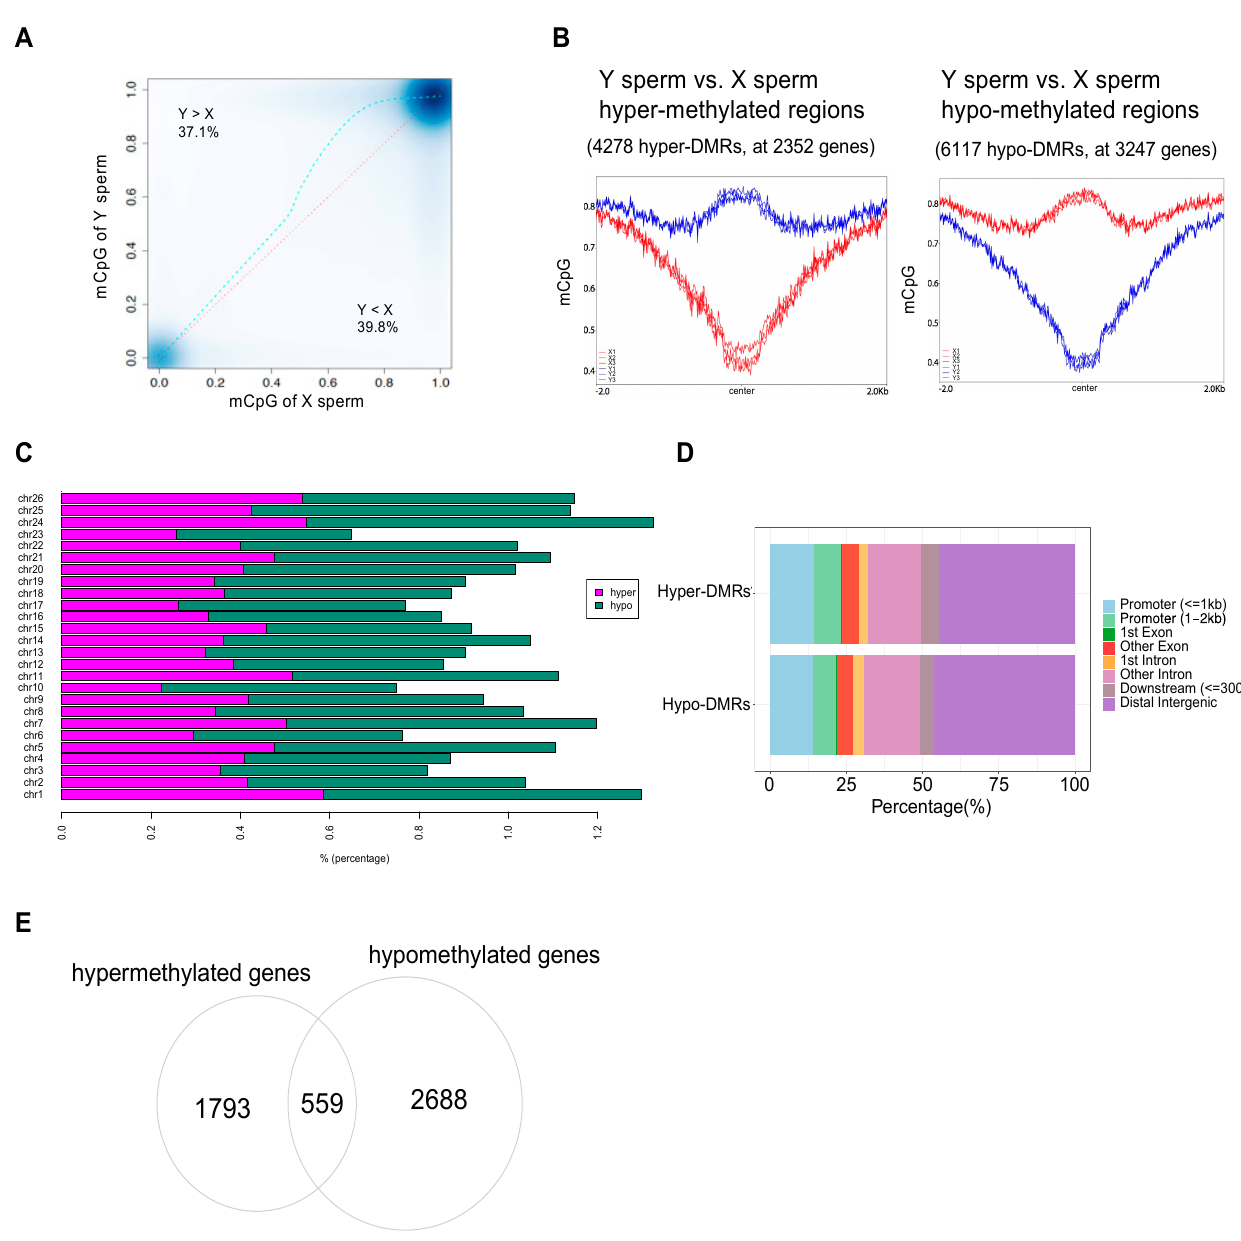
Figure 3. Genome-wide analysis of DNA methylation in X sperm and Y sperm. ( A ) Genome-wide hyper and hypomethylated CpG sites (Y sperm vs. X sperm). The red line represents the best fitting of linear regression, and the blue line is the smooth curve (Lowess method). ( B ) Average CpG methylation levels over ± 2 kb of all differentially methylated regions (DMRs) from Y sperm vs. X sperm. Left: hypermethylated regions; right: hypomethylated regions. Red: X sperm; blue: Y sperm. The thresholds for filtering of DMRs: methylation difference ≥ 25% and q value < 0.01. ( C ) Percentage of hyper and hypomethylated regions per chromosome. ( D ) Assignment of DMRs to different genomic regions. ( E ) Overlap of hypermethylated genes with hypomethylated genes, and their specific